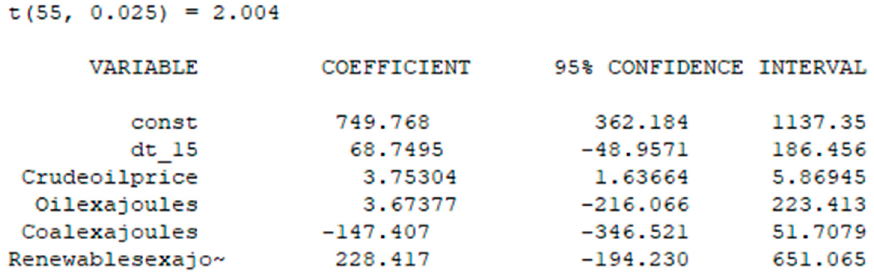
Figure 17. Test for adequacy.